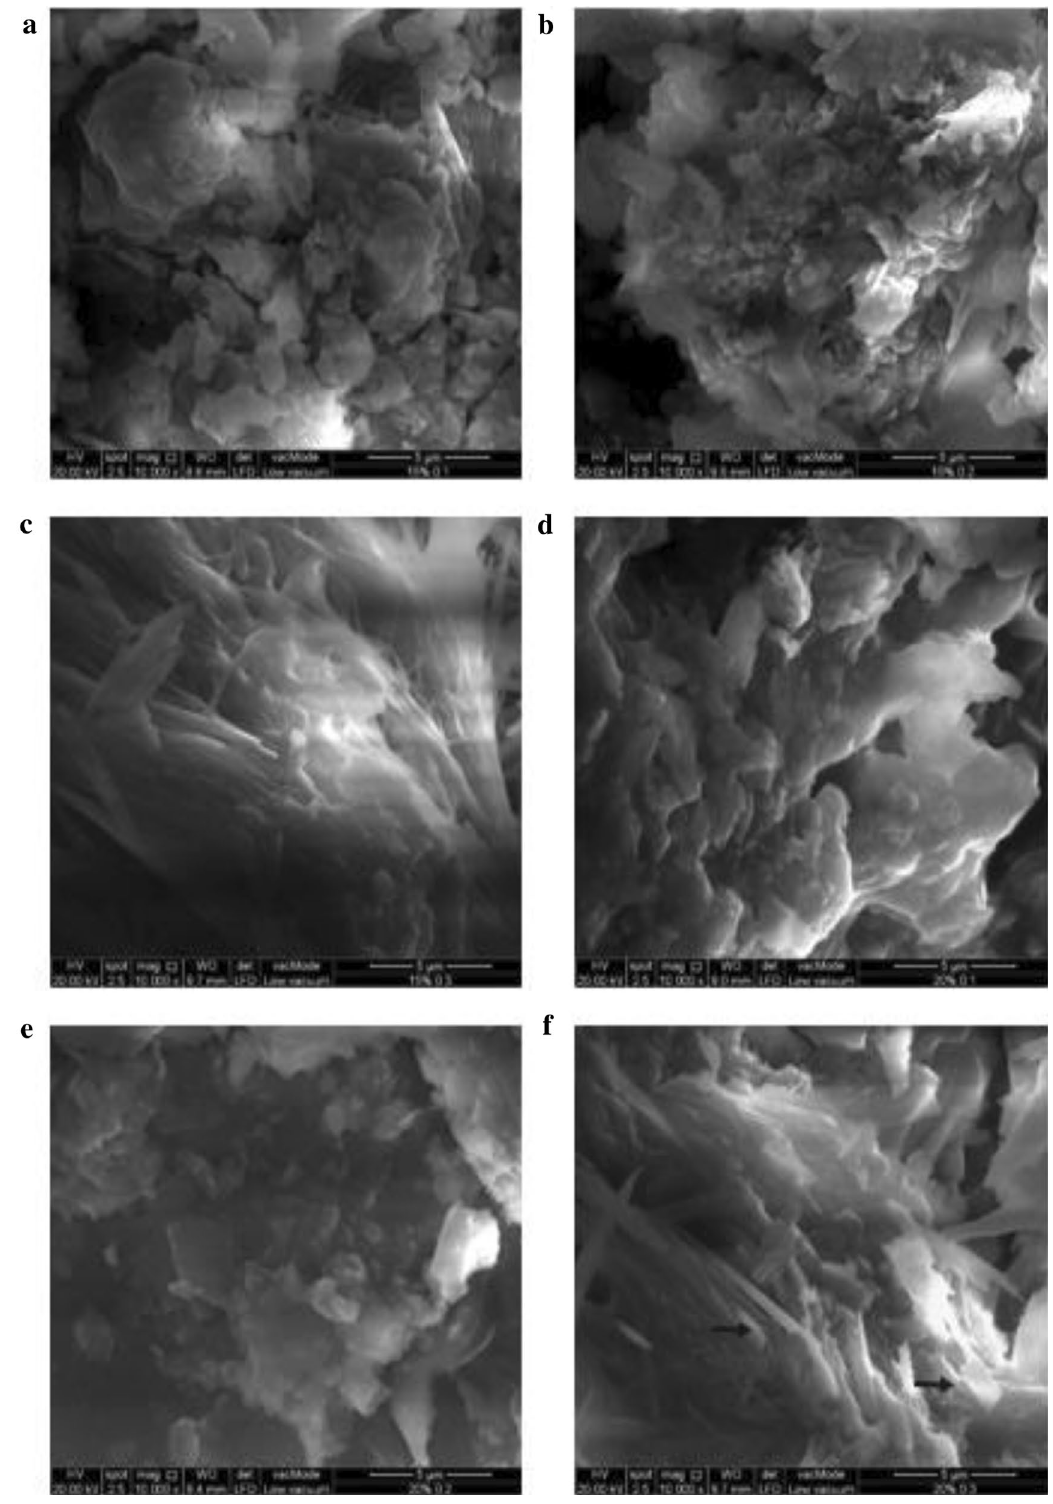
Figure 2. Specimen’s SEM morphologies ( a ) PP/15% n-HA/0.1% f-MWCNTs, ( b ) PP/15% n-HA/0.2% f-MWCNTs, ( c ) PP/15% n-HA/0.3% f-MWCNTs, ( d ) PP/20% n-HA/0.1% f-MWCNTs, ( e ) PP/20% n-HA/0.2% f-MWCNTs, ( f ) PP/20% n-HA/0.3%